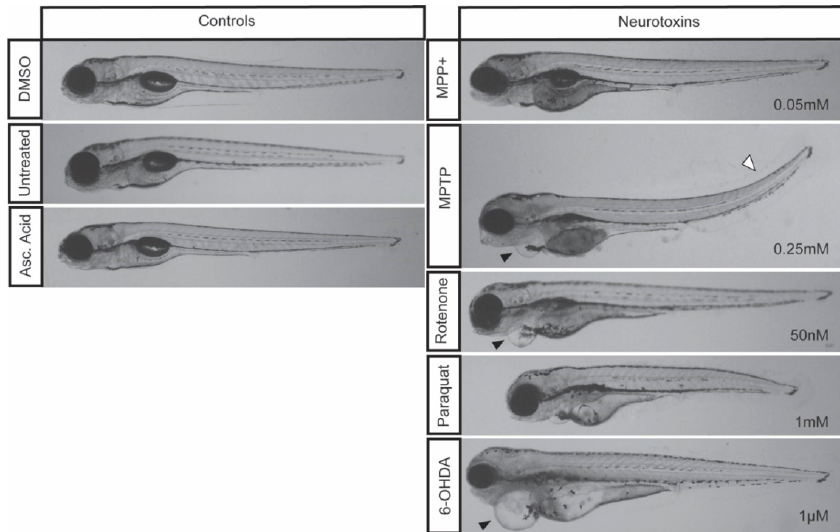
Figure 2. Zebrafish morphology following neurotoxic exposures. Larvae were exposed to 0.05 mM MPP + , 0.25 mM MPTP, 50 nM rotenone, 1 mM paraquat, and 1µM 6-OHDA starting at 3 dpf and imaged at 7 dpf. Control larvae were exposed to 0.1% DMSO, 0.1% ascorbic acid, or left untreated. Cardiac defects are depicted by a black arrowhead and a tail curvature is depicted by a white arrowhead. Refer to Table 2 for the frequency of each morphological malformation. Table 2. Summary of LC 50 neurotoxic effects of MPTP, MPP + , paraquat, 6-OHDA, and rotenone.